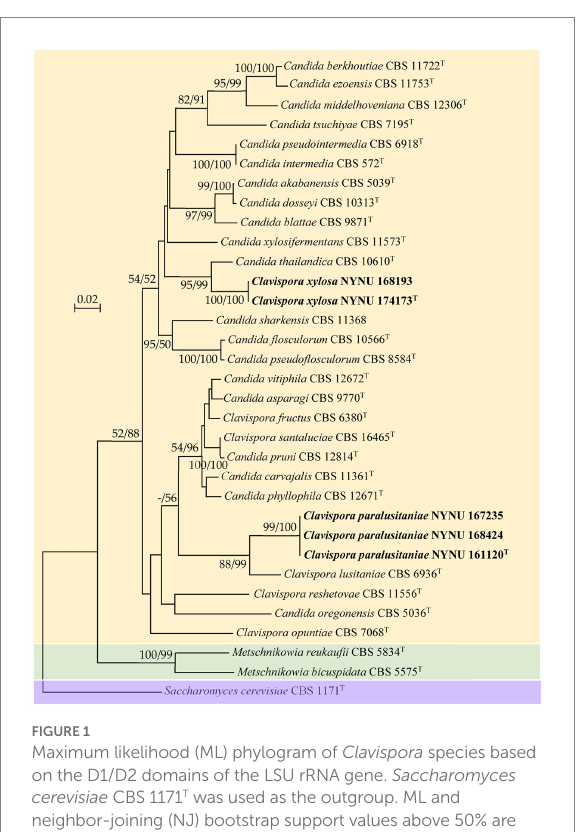
FIGURE 1 Maximum likelihood (ML) phylogram of Clavispora species based on the D1/D2 domains of the LSU rRNA gene. Saccharomyces cerevisiae CBS 1171 T was used as the outgroup. ML and neighbor-joining (NJ) bootstrap support values above 50% are shown at the nodes (ML/NJ). The novel strains described in this study are shown in